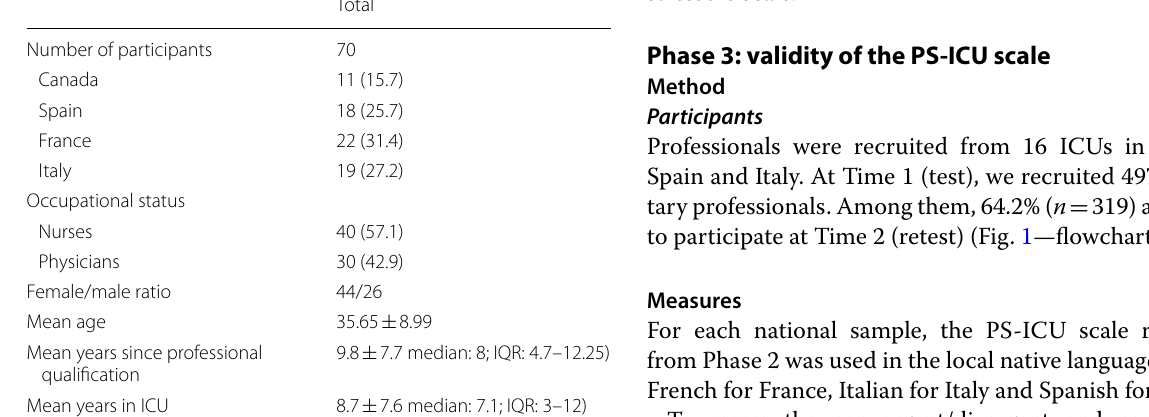
SD; IQR, interquartile range ±